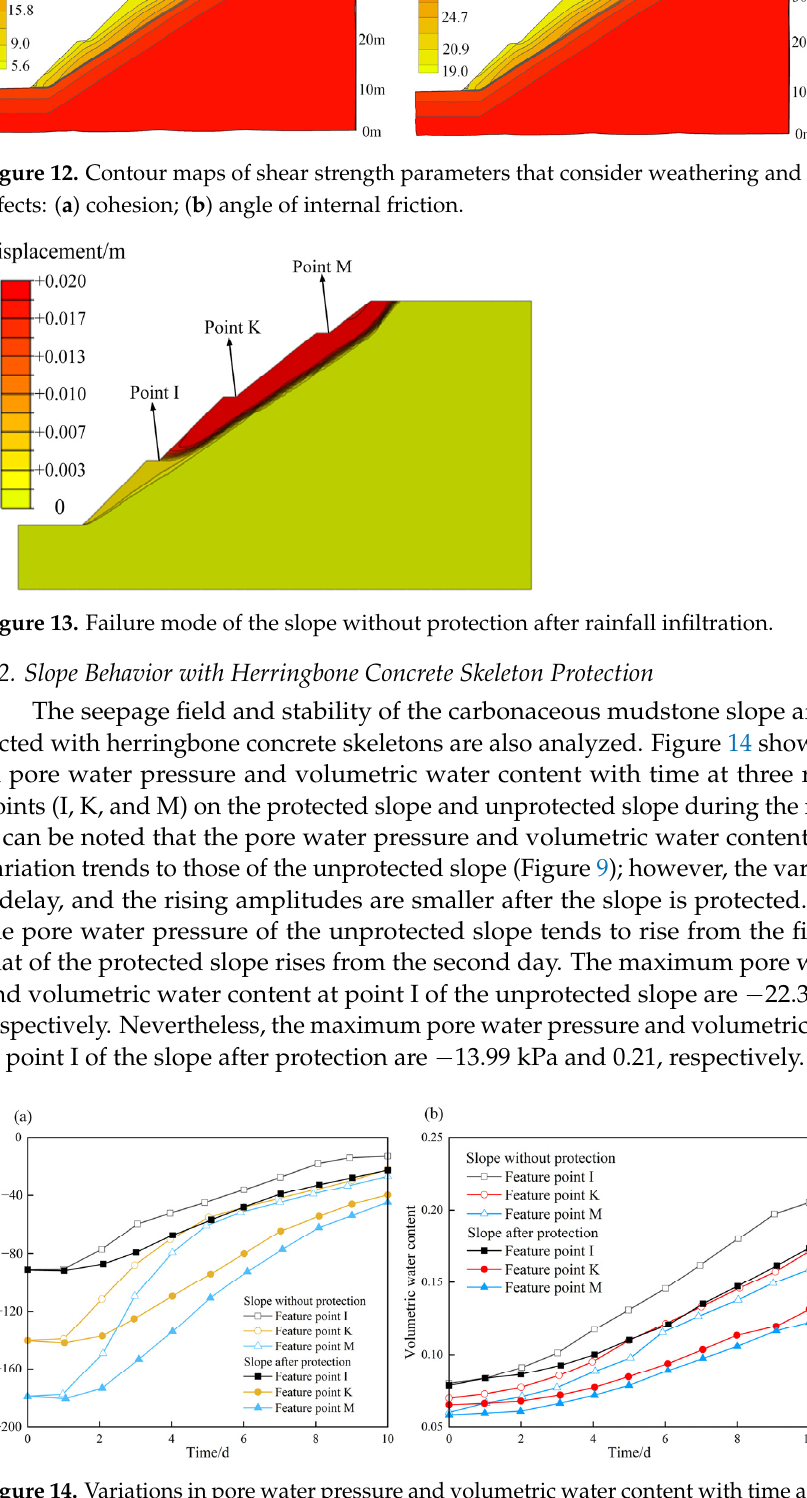
Figure 14. Variations in pore water pressure and volumetric water content with time at three positions on the protected slope: ( a ) Pore water pressure; ( b ) Volumetric water content.